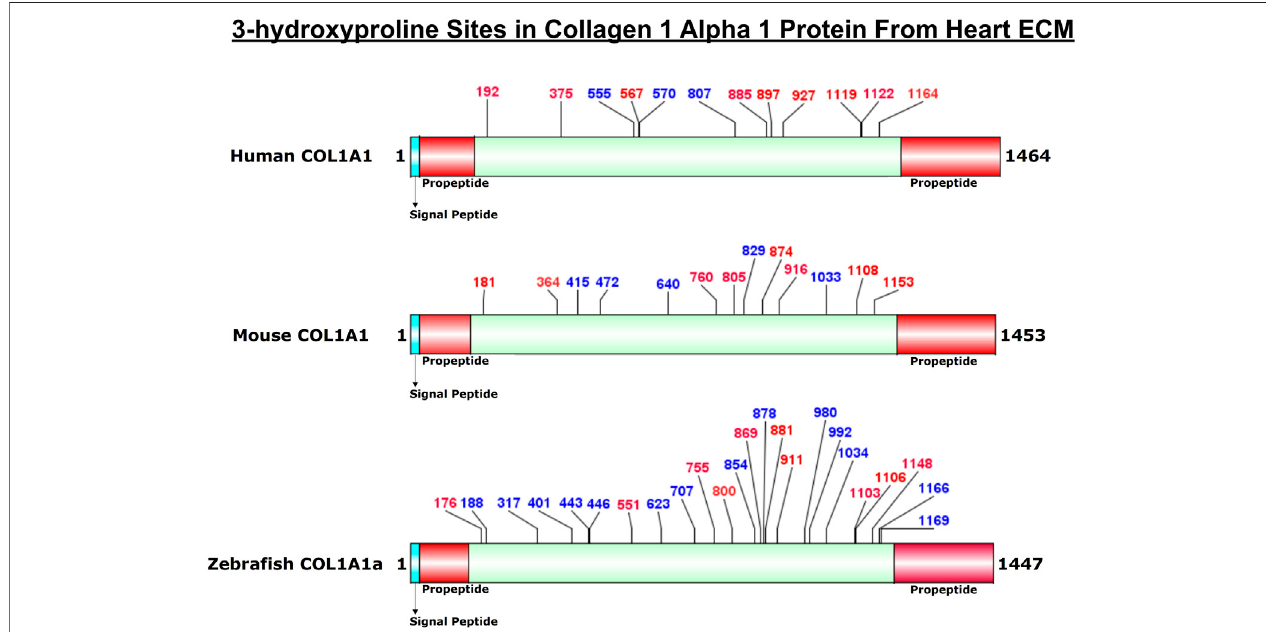
FIGURE4| Comparison of3-HyPsites identi fi edinCOL1A1afrom zebra fi sh heartECM toCOL1A1ofhumanand mice heart ECM. Thehorizontalboxrepresents thefull-lengthCOL1A1sequenceandtheverticalblacklinesindicatethecorresponding3-HyPsites.Theinformationfor3-HyPsitesofhumanandmiceheartECMwere re-analyzed in this manuscript from the available raw MS data from Barallobre-Barreiro et al. and Padmanabhan et al. The 3-HyP sites marked with red represent the conserved sites among human, mouse, and zebra fi sh.